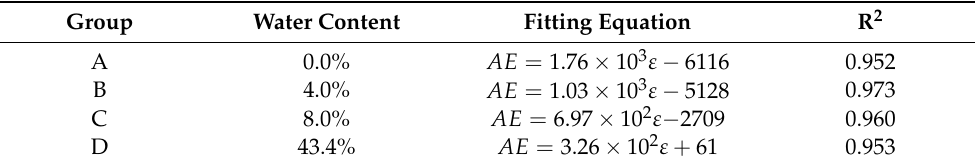
Table 5. Relationship between cumulative ringing count and axial